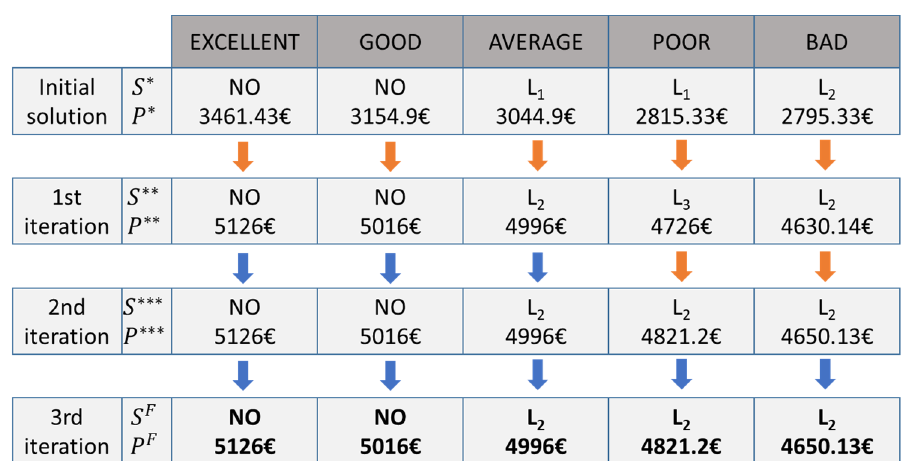
Figure 8. Computational results of maintenance strategy optimization based on Howard’s Policy Iteration Method (orange arrows: changing strategy, increased profit, decreased energy consumption, and decreased virtual GHG emission; blue arrows: unchanged strategy, profit, energy consumptions, and GHG emission).